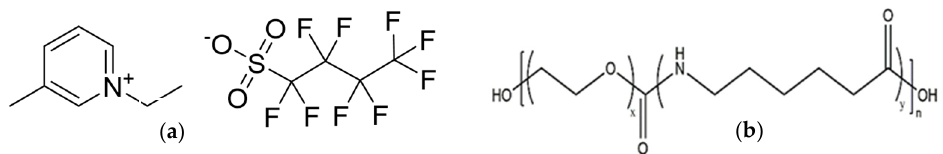
Figure 1. Structures of: ( a ) FIL used in this work, 1-ethyl-3-methylpyridinium perfluorobutanesulfonate ([C 2 C 1 py] [C 4 F 9 SO 3 ]); and ( b ) molecular structure of repeated unit of Pebax ®